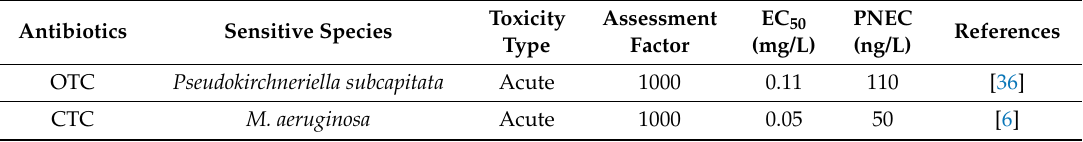
Table 3. Toxicity data of antibiotics corresponding to sensitive species.